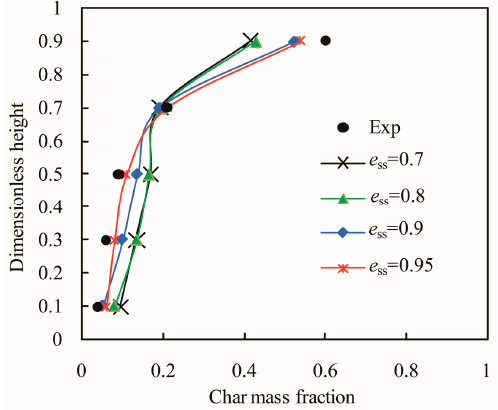
Figure 15. Effect of restitution coefficient on the axial mass fraction profile of the flotsam.